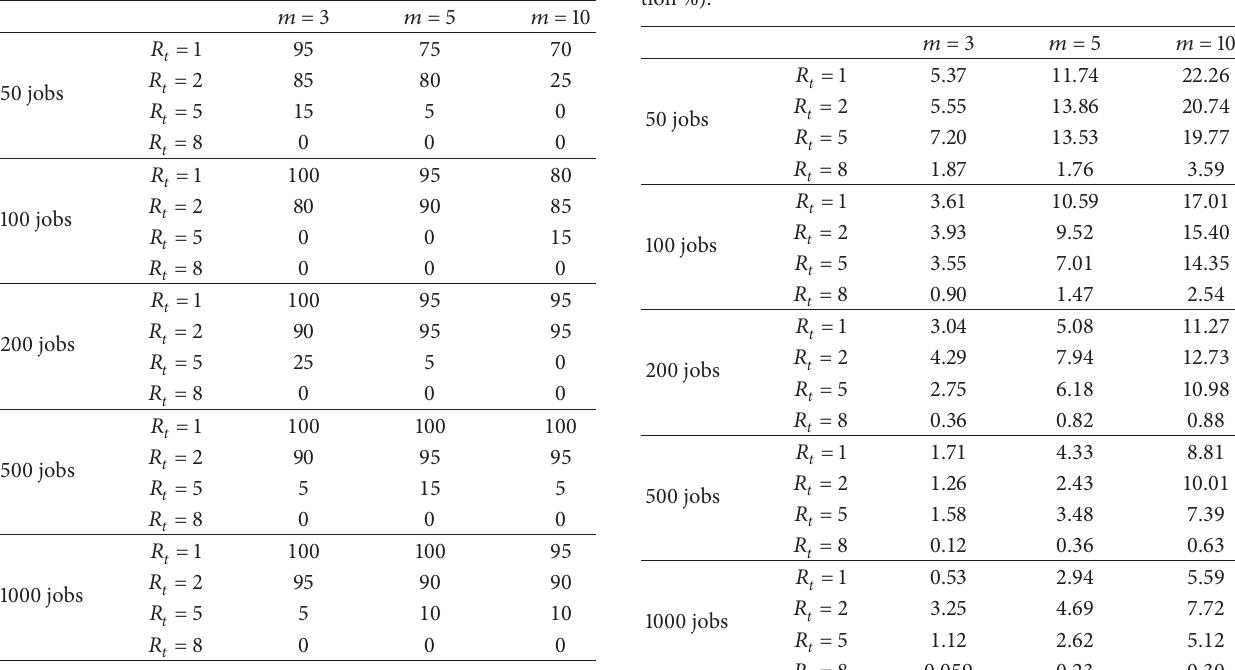
Table 3: Dominance tests of DSJF (uniform distribution %).